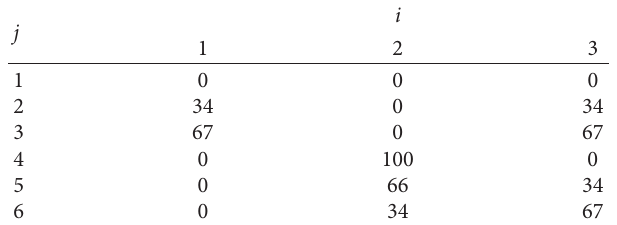
Table 7: Number of heavy